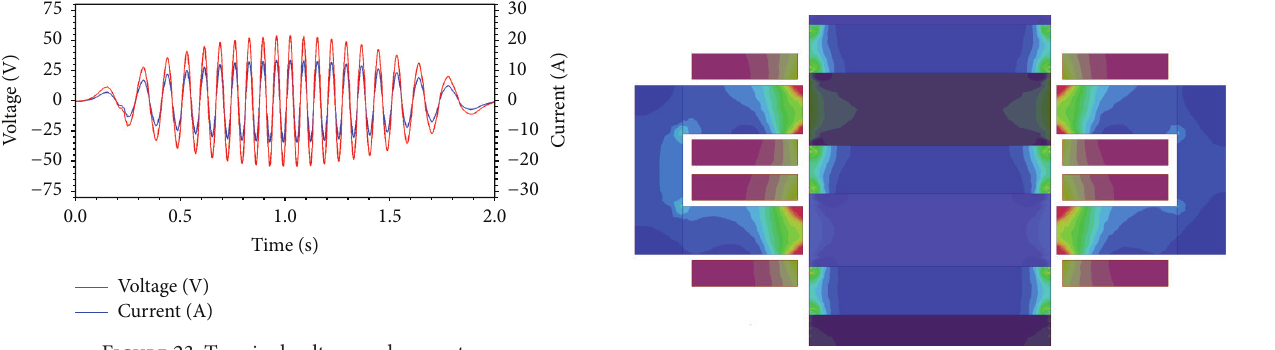
Figure 26: Magnetic flux density at 𝑡 = 20